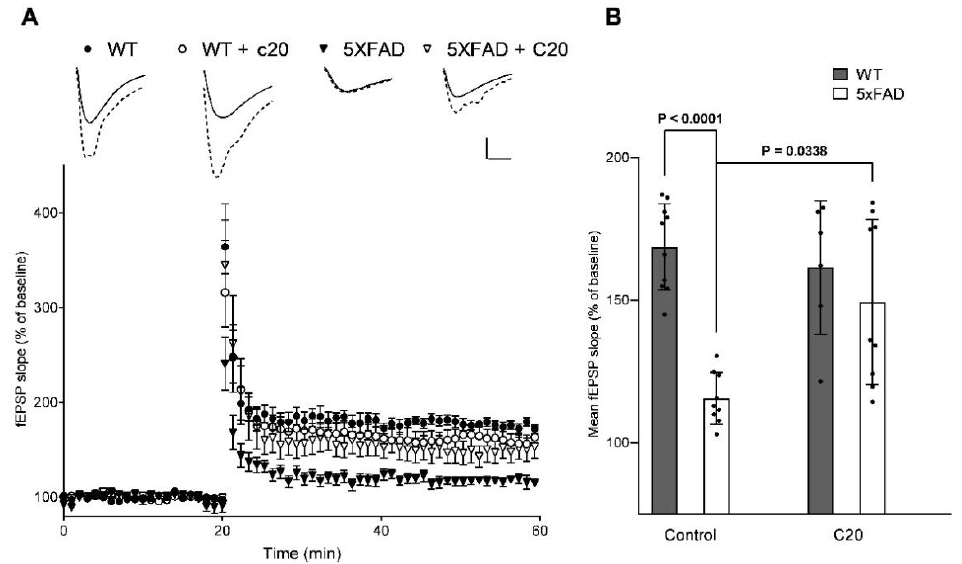
Figure 3. C20 restores LTP impairment in 8-month-old 5xFAD mice. ( A ) Summary plots of normal- ized fEPSP amplitude (%) in experimental groups. LTP was induced by high frequency stimulation (HFS). A total of 100 nM C20 was added to the perfusion system 10 min before the start of baseline recording. Error bars show SEM. Pictures above the plots are representative EPSPs from each group. Solid lines indicate baseline traces and the dotted lines are traces 30 – 40 min after HFS. Scale Bar 0.2 mV/10 ms ( B ) Cumulative data showing the average fEPSP slope 30 – 40 min after HFS (6 – 8 mice per group). Bars represent mean ± SEM. Sample distributions were assessed for normality (Shapiro – Wilk test) and homogeneity (Bartlett’s test). Statistical analysis was performed using Welch ANOVA following Games- Howell’s multiple comparisons test. P value s are indicated. [WT (n = 10 slices); WT + C20 (n = 6); 5xFAD (n = 9); 5xFAD + C20 (n = 9)].